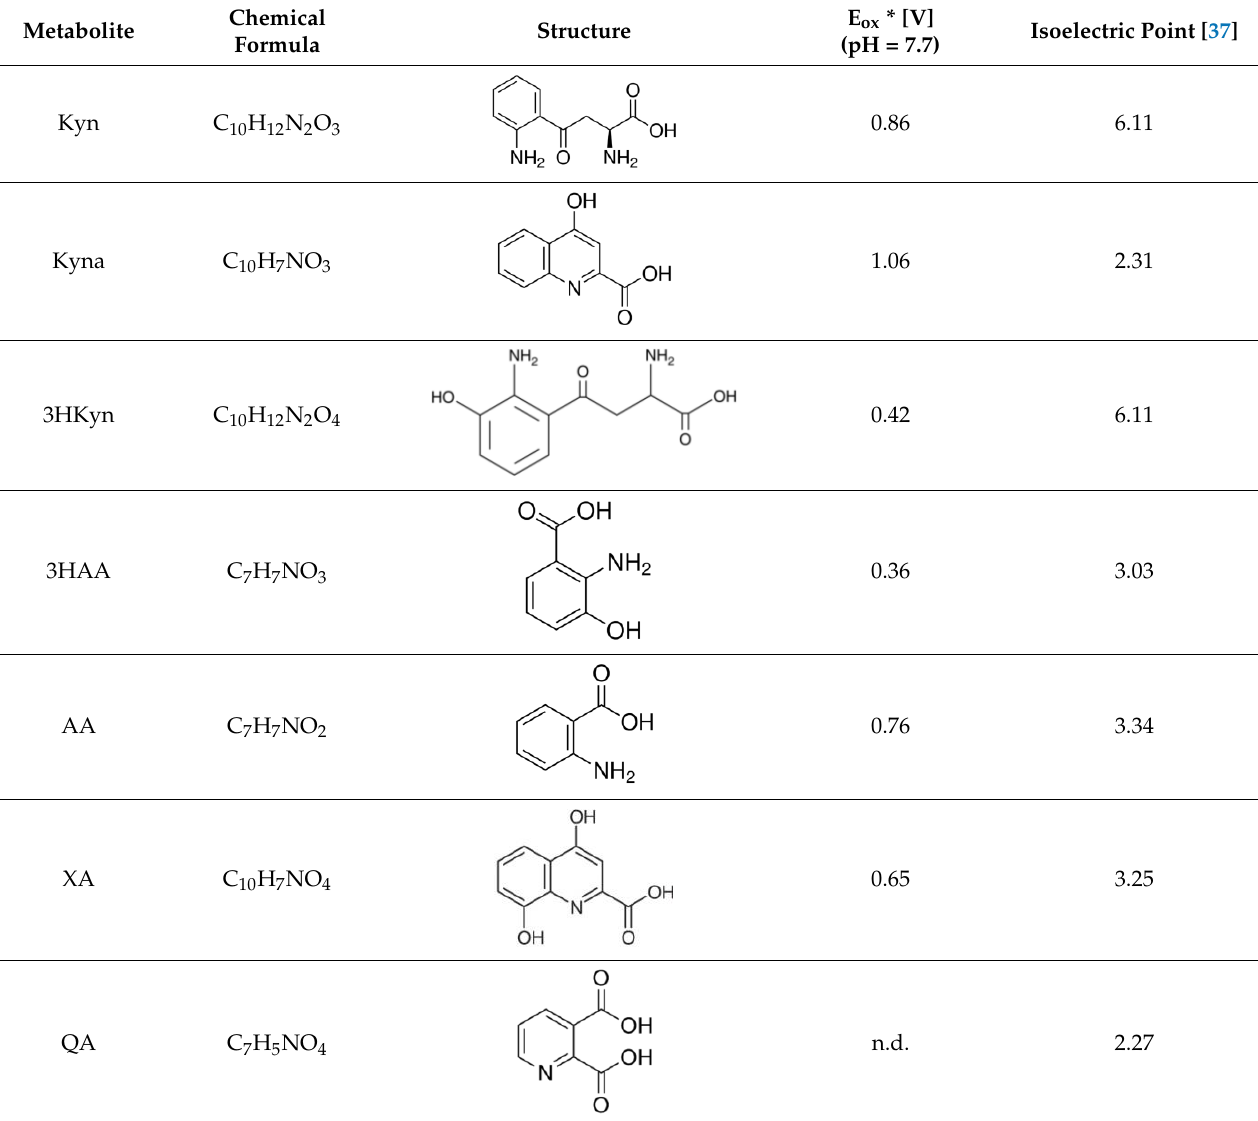
Table 4. Physicochemical properties and oxidation potentials of kynurenine pathway metabolites determined by DPV on GCE in 0.1 M PBS (pH 7.7).